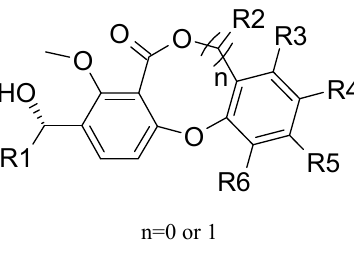
Figure 1. The structural core of lactone-based